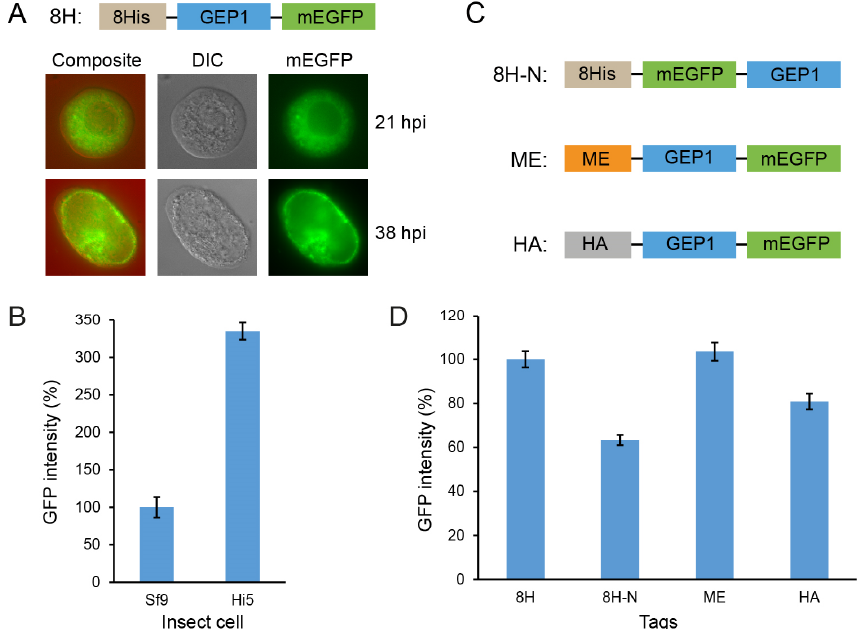
Figure 2. Localization and expression of GEP1 in insect cells. ( A ) Localization of mEGFP-labeled GEP1 in Hi5 infected cells. Differential interference contrast (DIC), monomeric enhanced green fluorescent protein (mEGFP). Cells were examined by inverted fluorescence microscopy. ( B ) Expression levels of GEP1 in both Sf9 and Hi5 insect cell lines. ( C , D ) Constructs with different tags on GEP1 and protein expression levels detected by GFP intensity. ME: Honey bee melittin signal peptide; HA: haemagglutinin signal peptide. The GFP intensity in the supernatant was measured after extraction with detergent, detected by a microplate reader (excitation 485 nm, emission 528